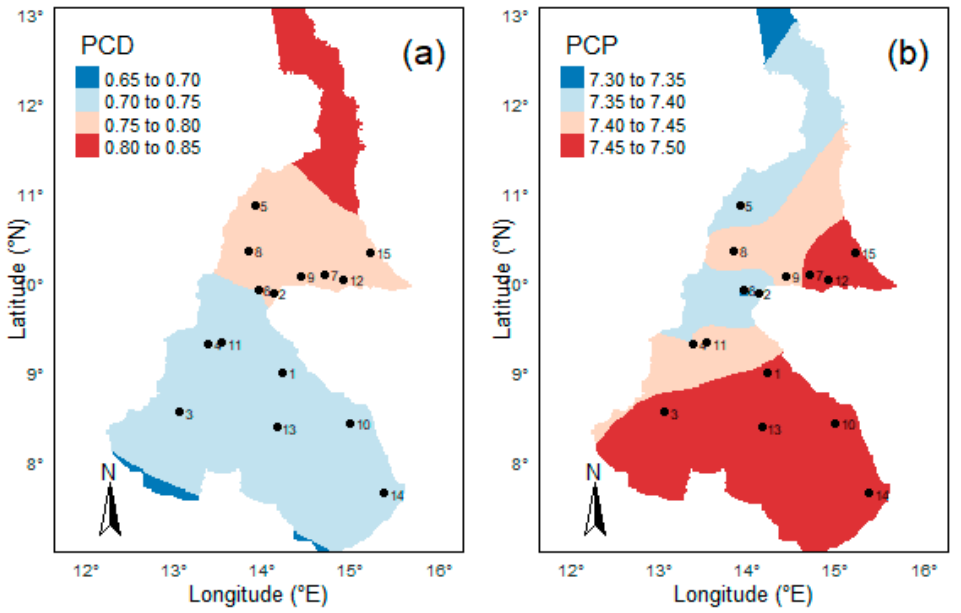
Figure 3. Spatial distribution of the mean annual values for variability parameters from 1980 to 2018. ( a ) Precipitation concentration degree (PCD), and ( b ) Precipitation concentration period (PCP). Mean PCP ranged from a minimum of 7.36 in Guetale to a maximum of 7.50 in Touboro and Tchatibali, which implied that annual rainfall mainly fell in July. The finding indicates that the wet season arrived earlier in the central and far north regions of the study area. The trend directions of PCP showed increasing trends for 12 out of 15 stations, with only three sites (Hina-Marbak, Kaélé, and Yagoua) decreasing at the 90% level. This indicates that the rainy season exhibited a very slight temporal change in an increasing direction over the period 1980–2018, implying a slightly later occurrence of precipitation (Figure 3b).